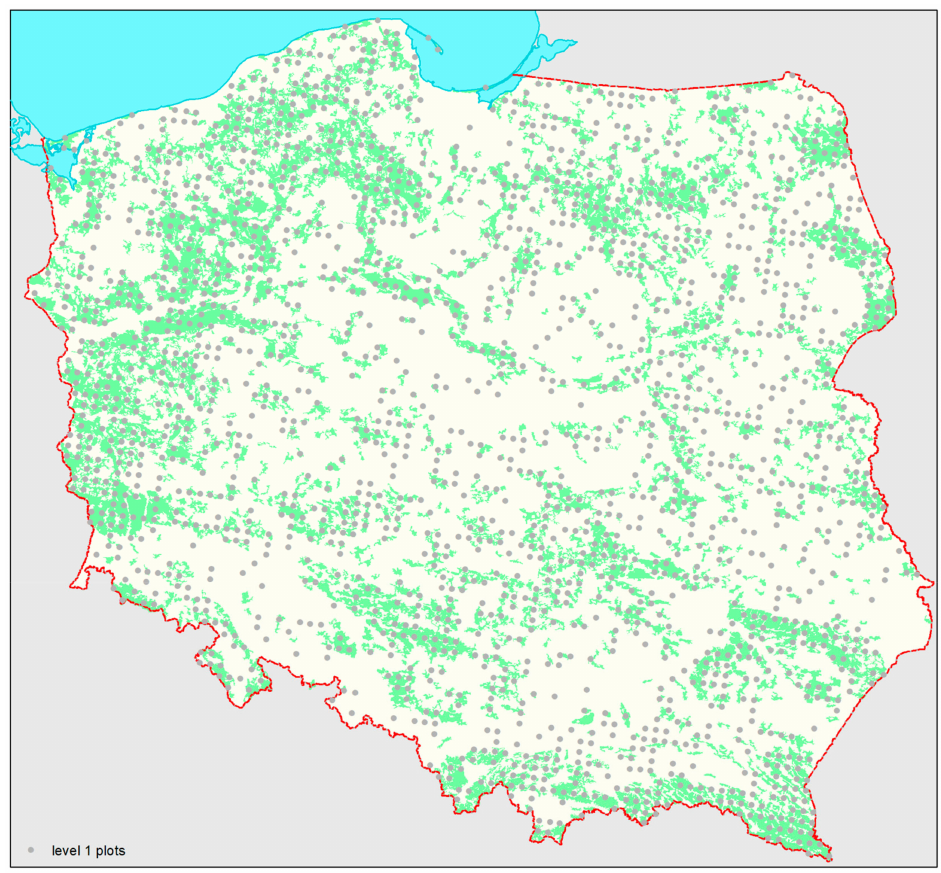
Figure 1. Location of forest monitoring level 1 plots in